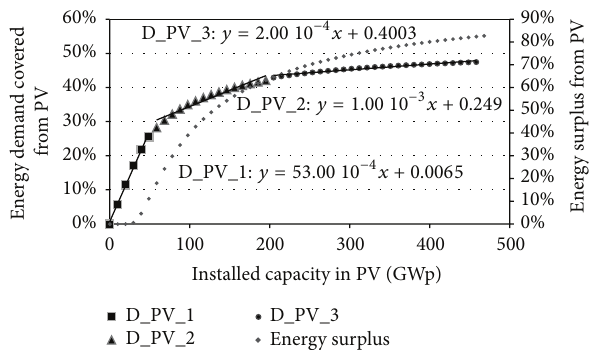
Figure 8: How does energy demand covered from PV and resulting energy surpluses change for different values of installed capacity in PV. Key: D PV 1 and so forth (denoted by square, triangle, and circle) represent current demand covered from PV; in respective ranges they were approximated by linear regression